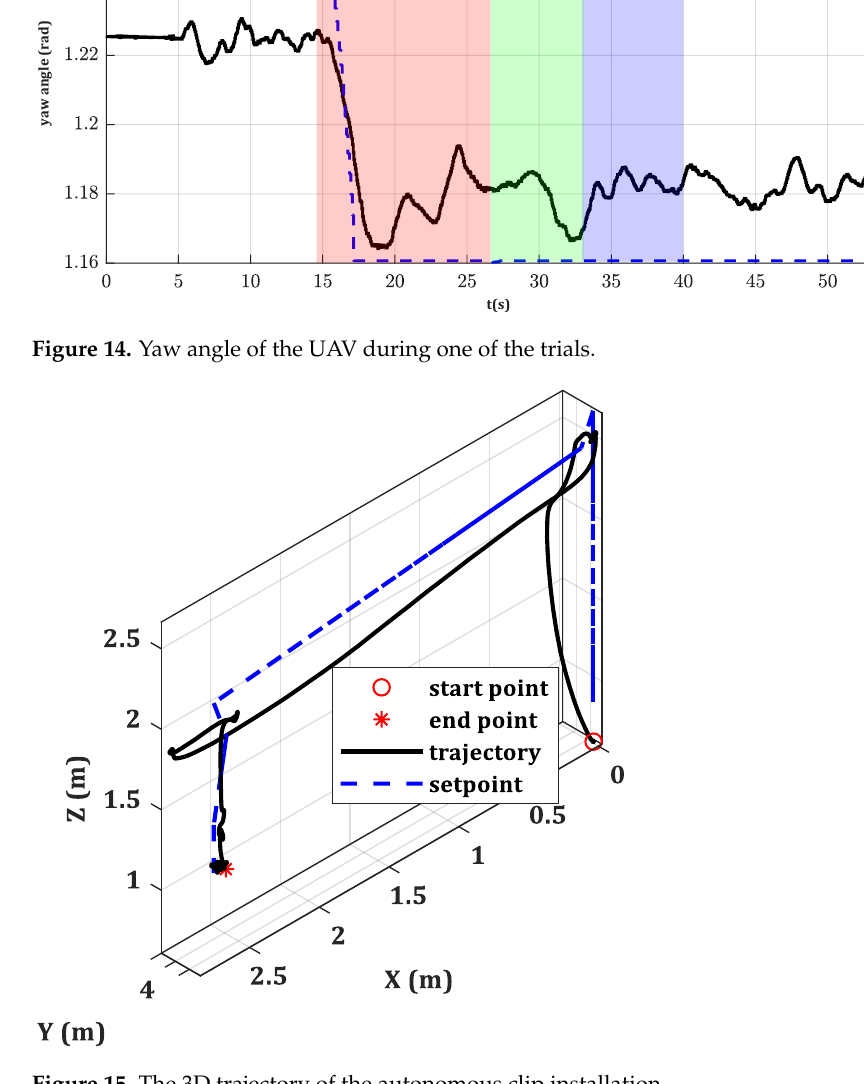
Figure 15. The 3D trajectory of the autonomous clip installation.